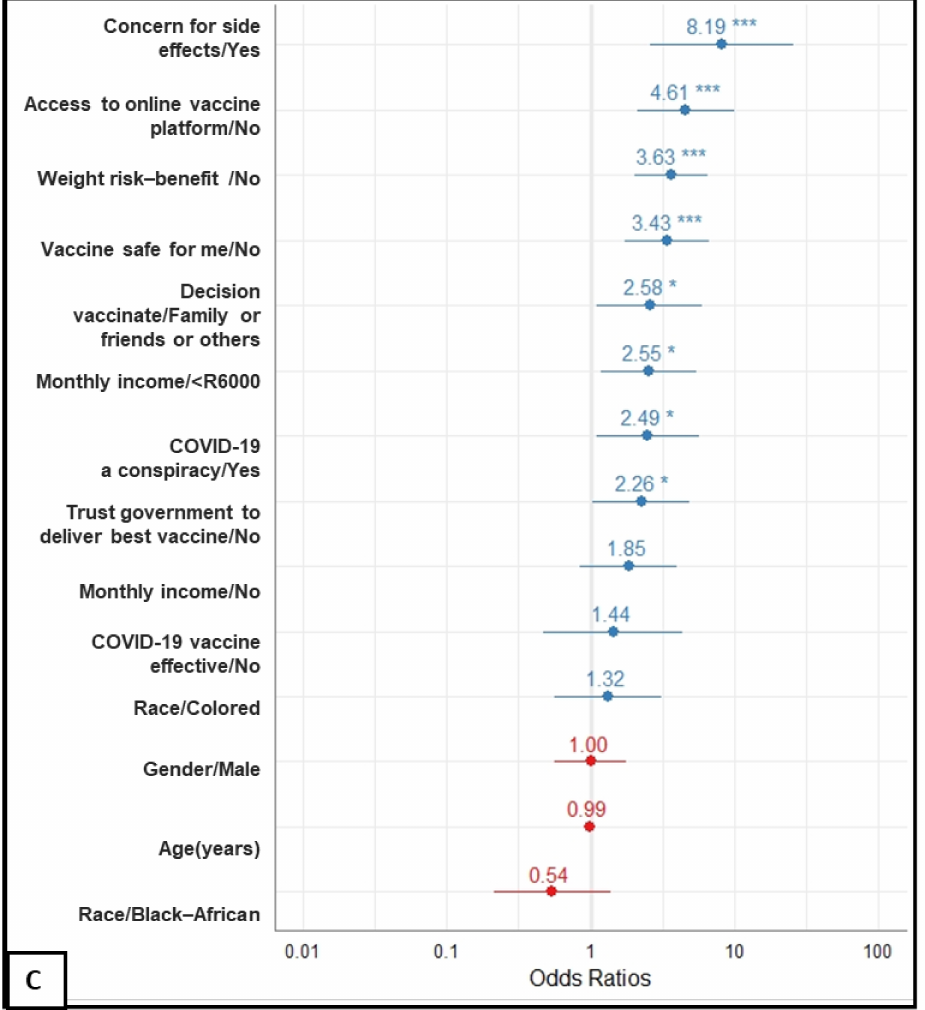
Figure 2. Forest plots displaying factors associated with vaccine hesitance among respondents from four local communities in South Africa, from 6 June to 30 June 2021. Plots ( A – C ) indicate models adjusted for sociodemographic factors, COVID-19 related factors and combination of ( A , B ), respectively. Of note, all models are adjusted for gender (binary) and for age (continuous). The vertical line, slightly thicker than the other grid lines (x-axis position 1) indicates the neutral line, i.e., the vertical intercept that indicates no effect. Points in the plots and related horizontal lines represent the estimated odds ratio and their corresponding 95% confidence interval (CI) of COVID-19 vaccine hesitancy defined as uncertainty or intention to refuse COVID-19 vaccination, respectively. Blue and red colors indicate odds of hesitancy and of acceptance respectively. Asterisks indicate the significance level of the p -values (*: p < 0.05, **: p < 0.01, ***: p < 0.001). Exact 95% CI and p -values are provided in Table